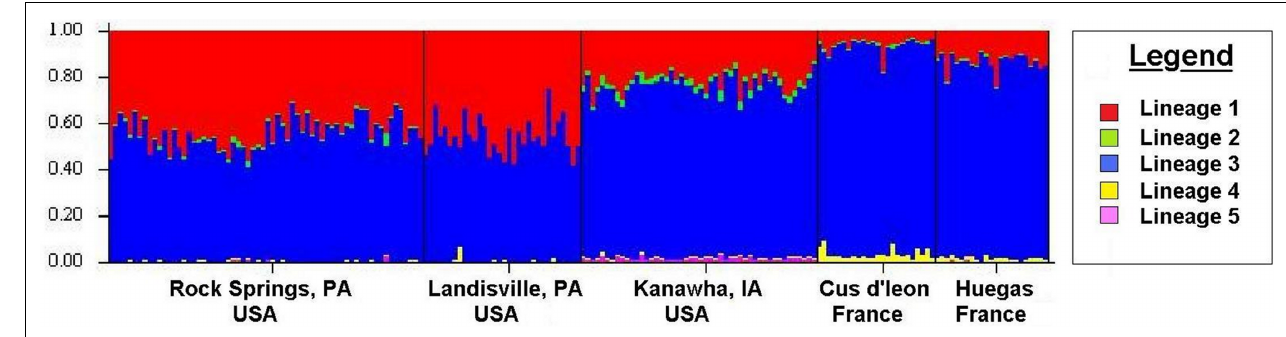
subpopulations. Each of the 189 individual O . nubilalis genotypes are represented as a vertical line and are composed of proportions of each K th segment which represent genetic lineages within the respective individual.